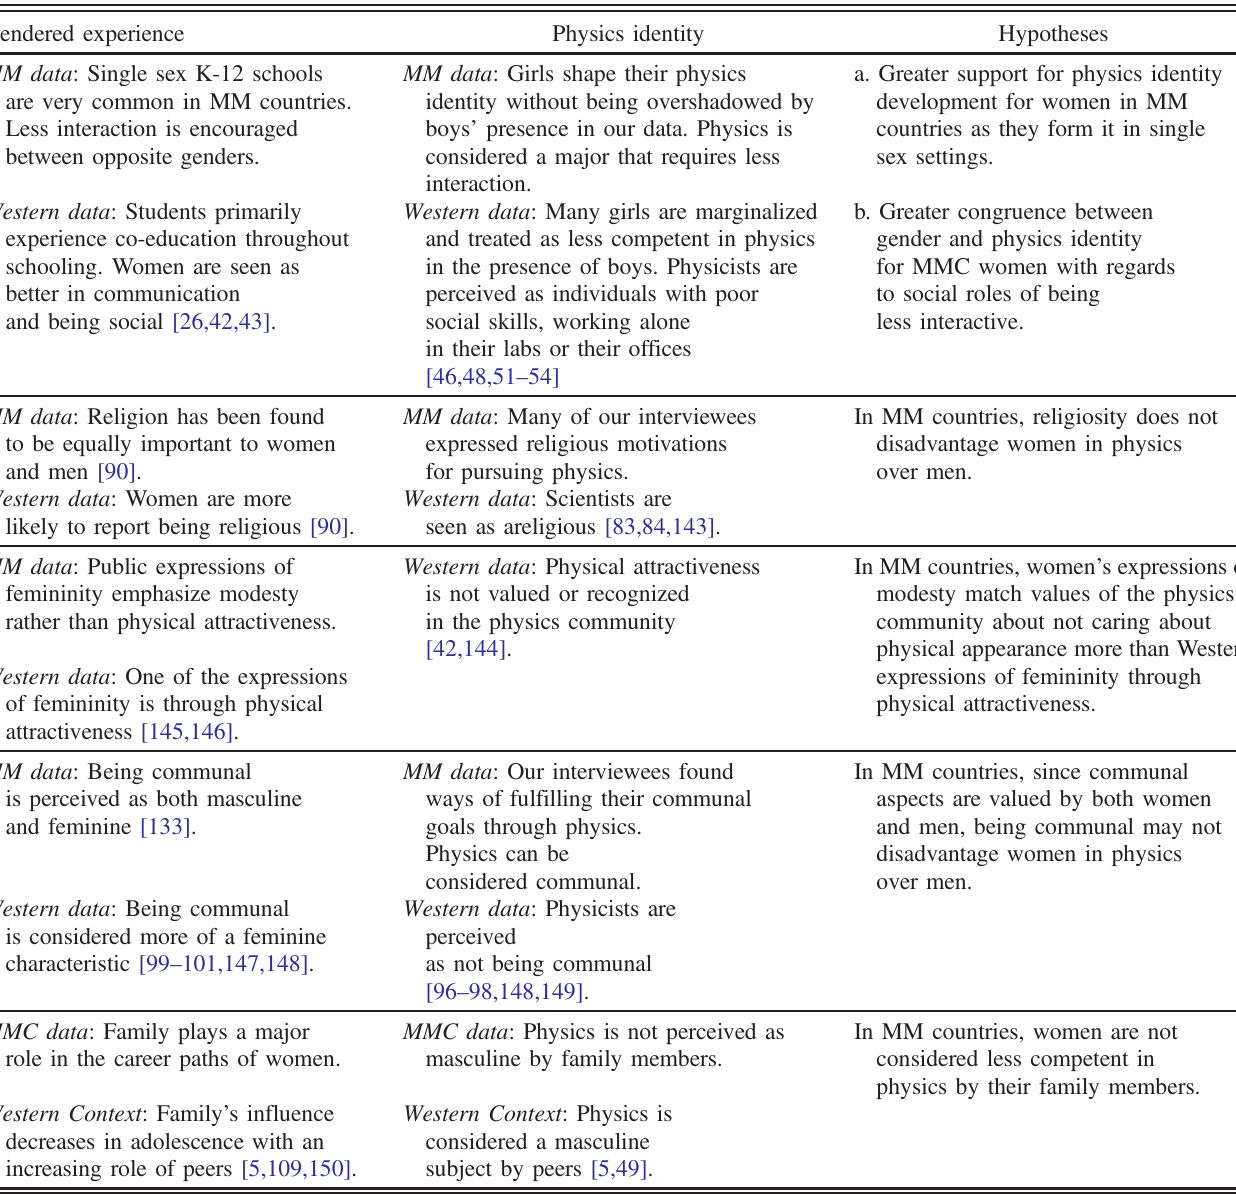
TABLE II. Hypotheses emerging from the interviews. Gendered experience MM data : Single sex K-12